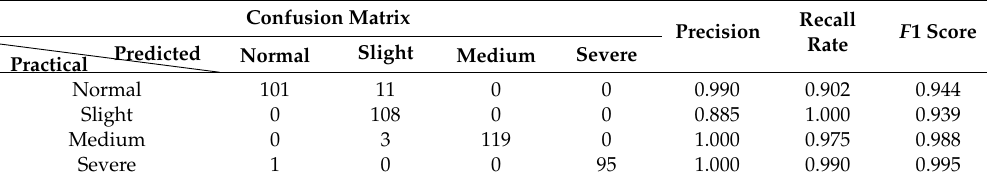
Table 5. Evaluation indexes of the model using test